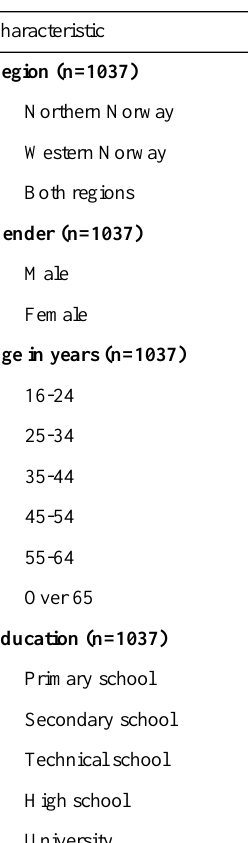
Table 1. Characteristics of the